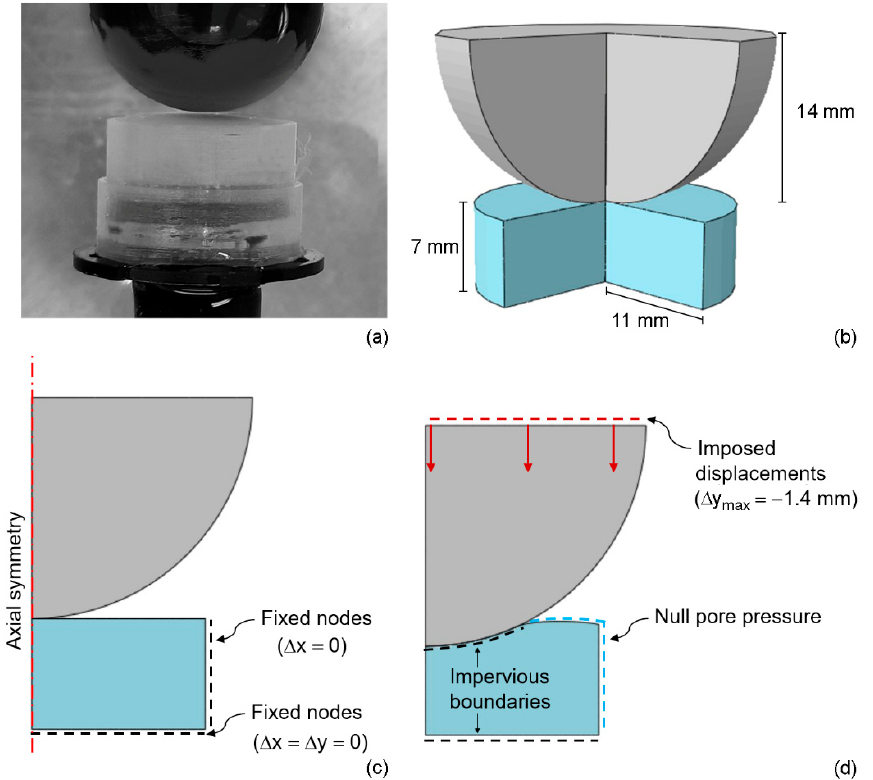
Figure 1. ( a ) Experimental setup for indentation and consolidation tests: detail of sample surface and indenter before testing. ( b ) Numerical model: cut-out view of the 3D geometry with size of sample and indenter; ( c ) axisymmetric FE model adopted for the analyses with indication of fixed displacement boundary conditions; ( d ) imposed displacements and fluid phase boundary conditions.